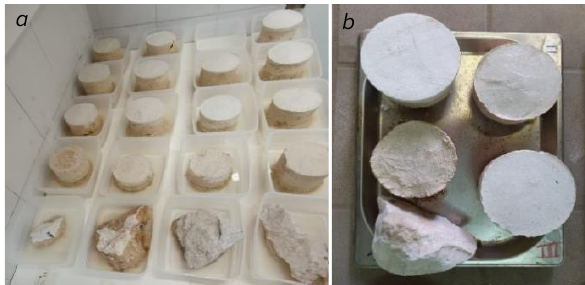
Figure 6. (a) The impregnation process. (b) A group of samples